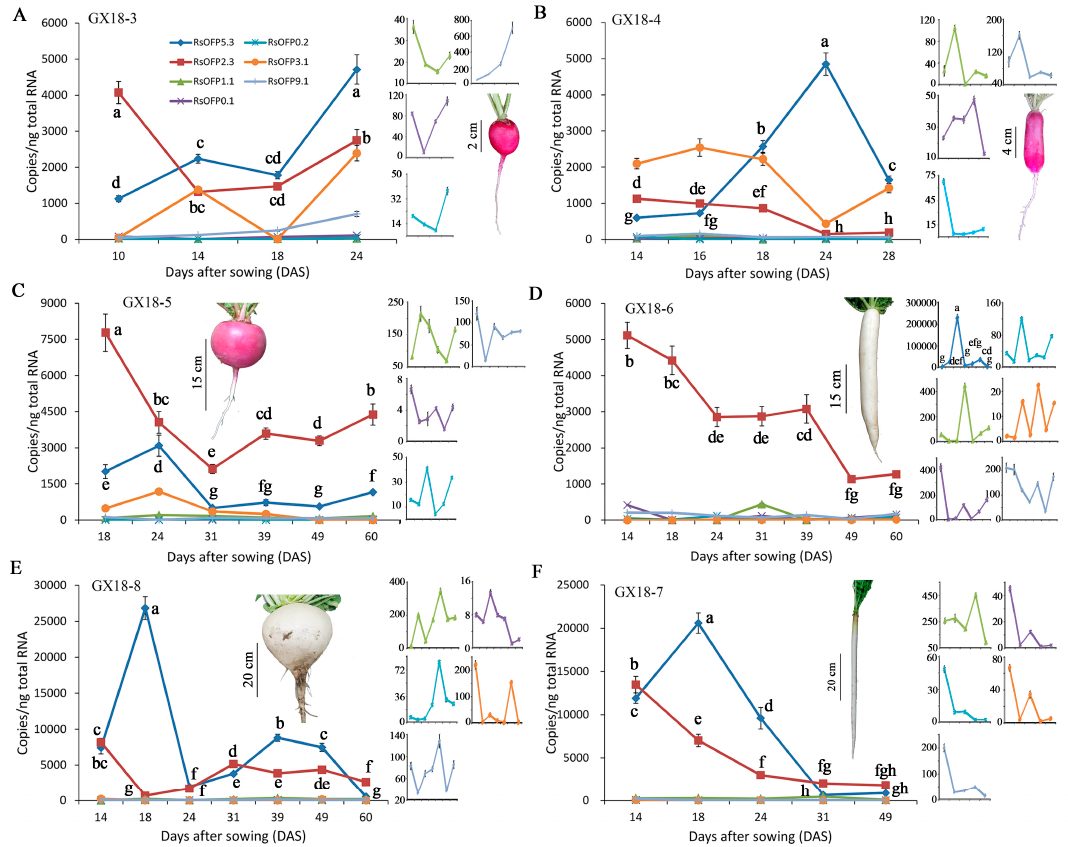
Figure 4. Expression profiles of seven RsOFP genes ( RsOFP5.3 , RsOFP2.3 , RsOFP1.1 , RsOFP0.1 , RsOFP0.2 , RsOFP3.1 , RsOFP9.1 ) in six radish cultivars during tuberous root development, including GX18-3 ( A ), GX18-4 ( B ), GX18-5 ( C ), GX18-6 ( D ), GX18-8 ( E ), and GX18-7 ( F ). Genes with low expression are shown beside each chart. Error bars on each point indicate ± SE from at least three independent replicates. Di ff erent letters indicate significant di ff erences as determined using ANOVA, followed by Tukey’s HSD test (P<0.05).